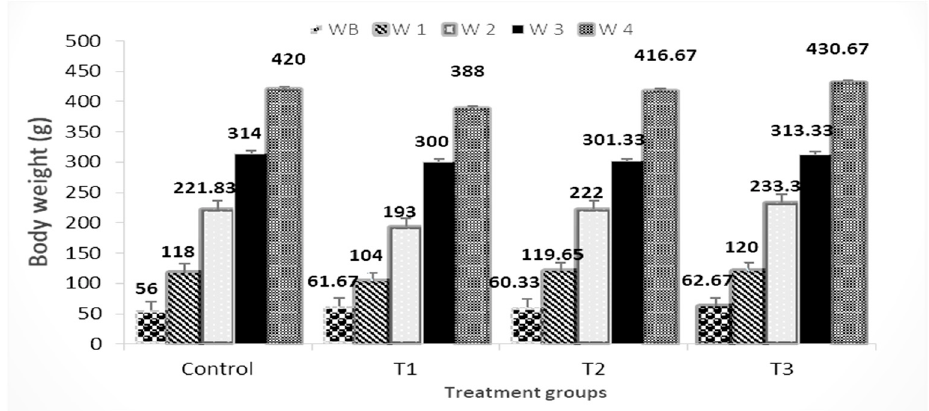
Figure 3. Effect of pomegranate peel and garlic powder separately or in combination on the weight of births at different times (W 1, W 2, W 3, and W 4 are presented weeks 1, 2, 3, and 4 respectively). Values are presented as means ± SE (n = 5 litters). T1; pomegranate peel 3%, T2; garlic 3%, and T3; pomegranate peel 1.5% + garlic 1.5%.